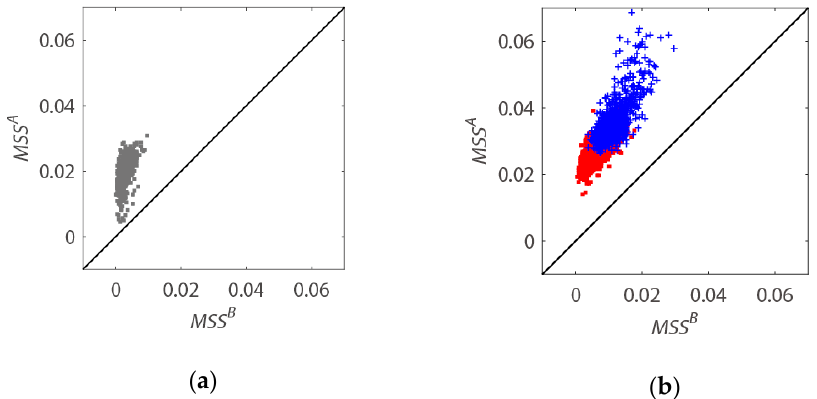
Figure 5. Buoy MSS B and altimeter MSS A when the wind speed is lower ( a ) or higher ( b ) than 5 m·s − 1 . In the right-hand panel, the blue (red) plots indicate data for the case in which the wind speed is higher (lower) than 10 m·s − 1 .